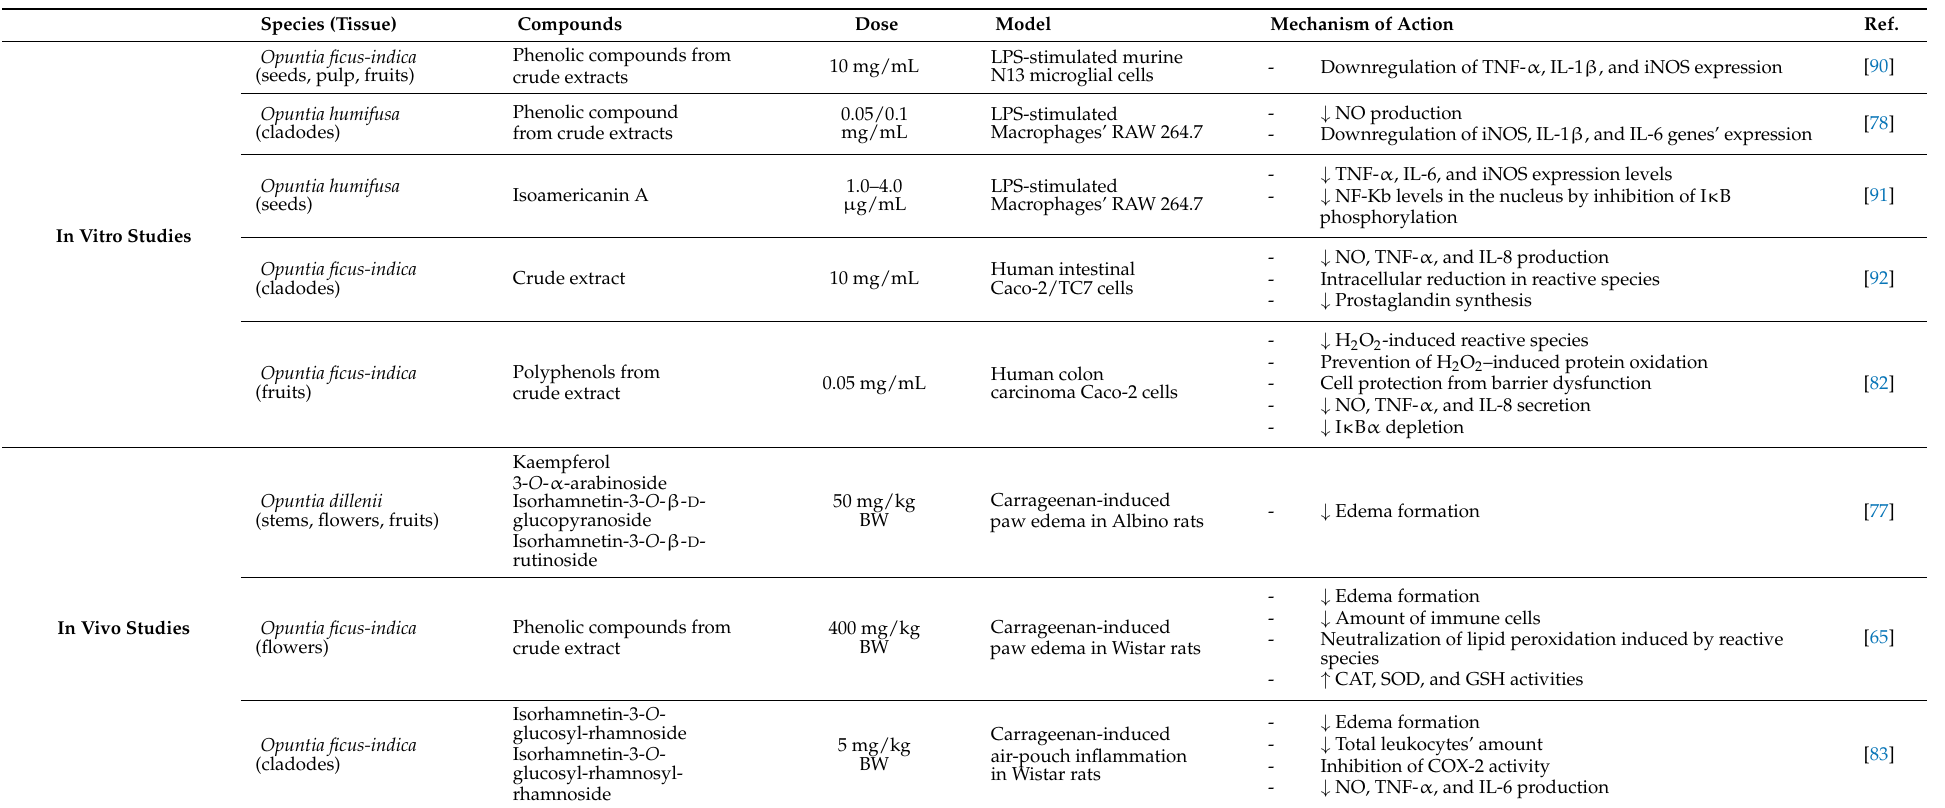
Table 2. Anti-inflammatory potential and mechanism of action of phenolic compounds extracted from Opuntia species 1